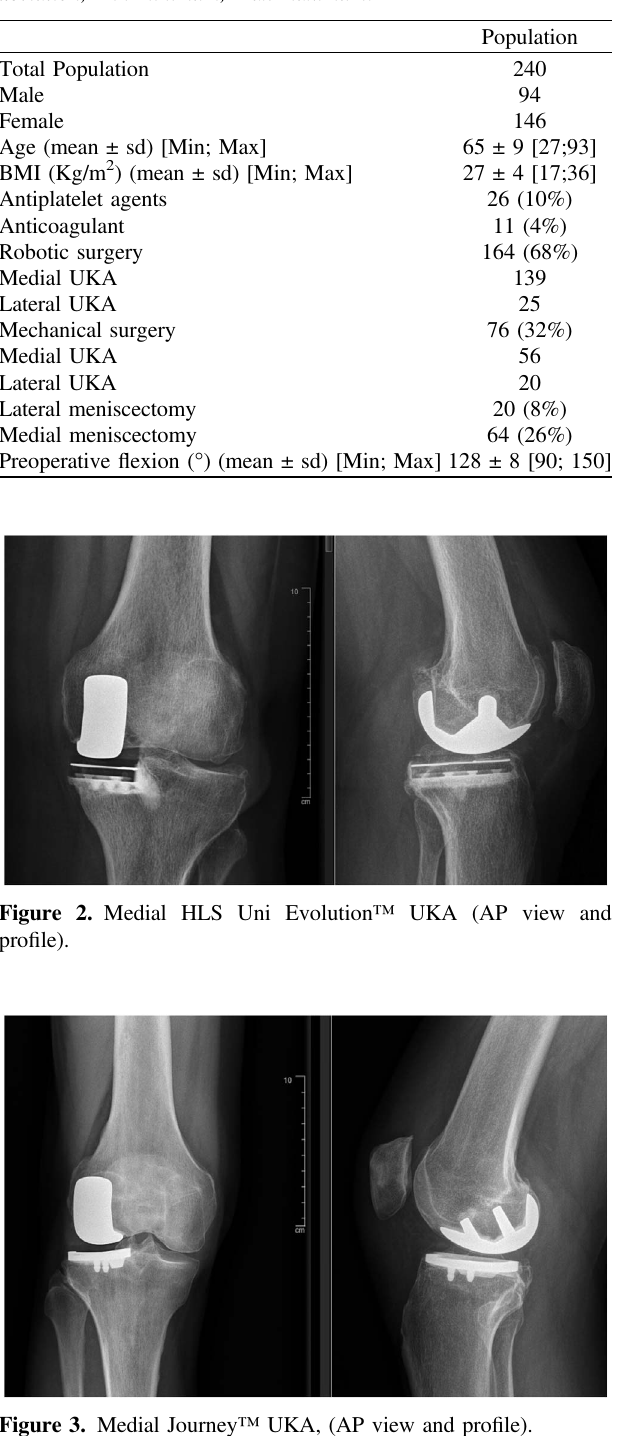
Table 1. Final study population characteristics SD standard deviation, Min minimum, Max maximum .